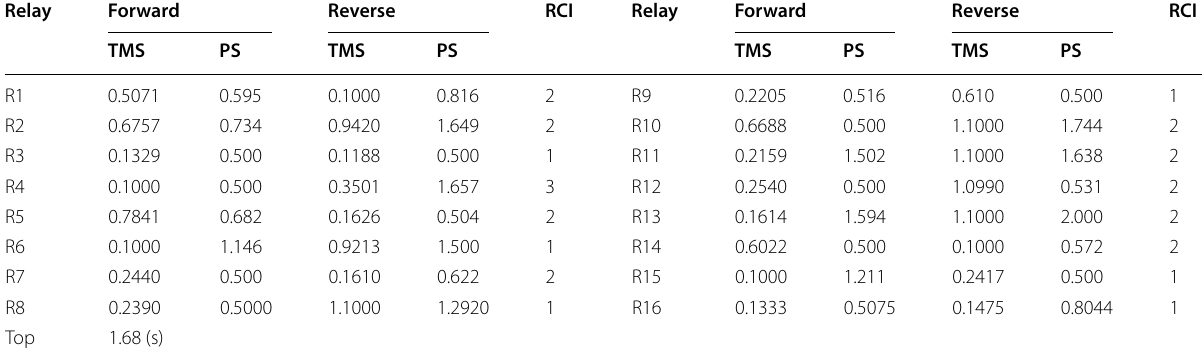
Table 8 Common optimal relay setting using dual setting DOCR for 7-bus microgrid system Relay